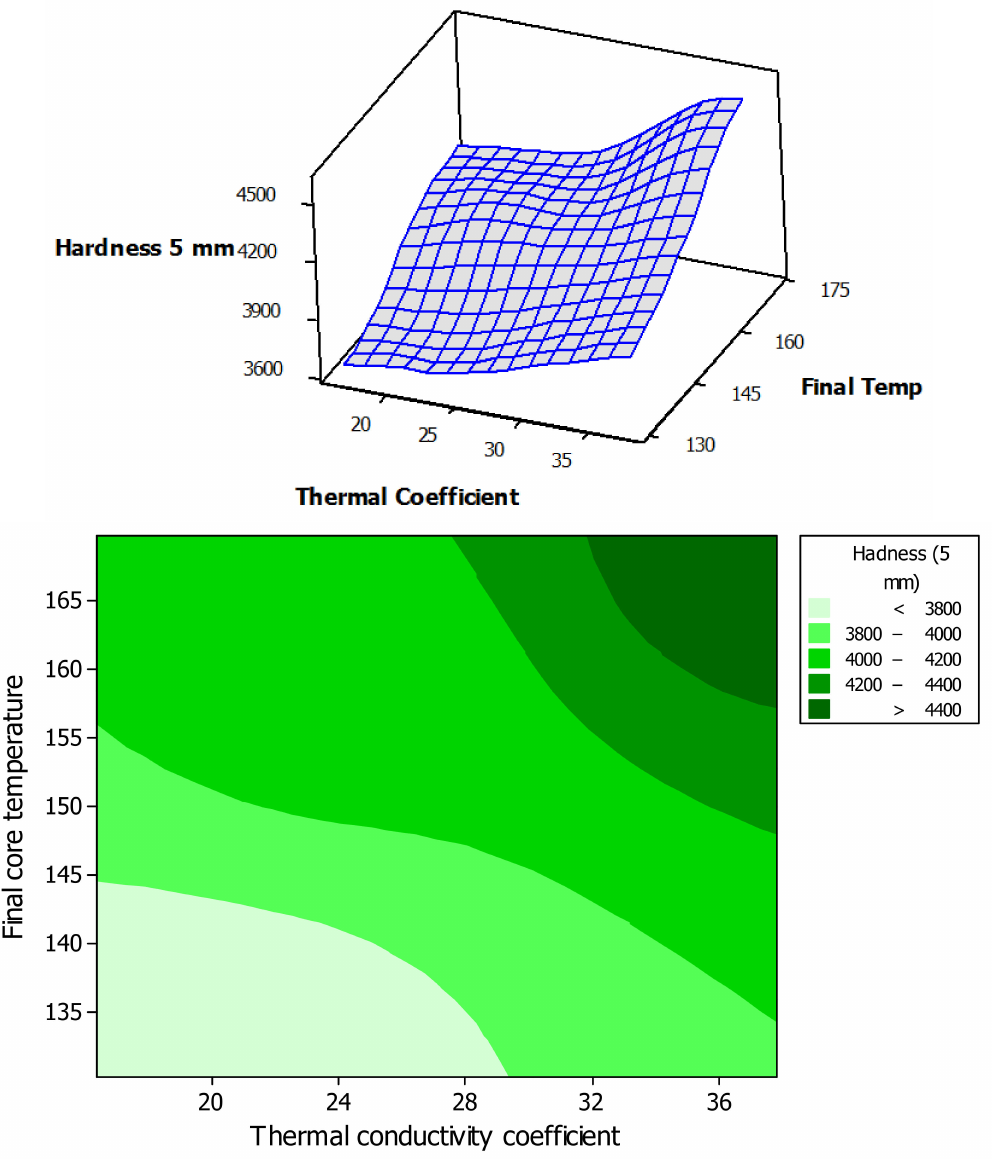
Figure 10. Surface analysis (A) and contour plot (B) among hardness (at 5 mm depth of penetration), versus final core temperature (at 480 s) and thermal conductivity coe ffi